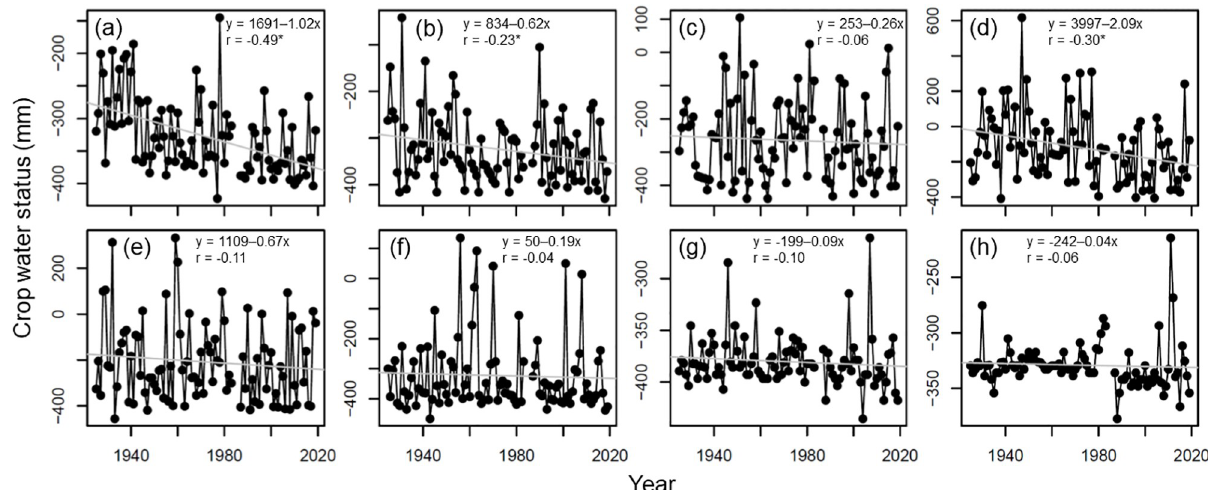
Fig 3. Yearly trend of crop water status on rice growth under initial (a and e), crop development (b and f), reproductive (c and g), and maturity (d and h) stages in cool (a, b, c, and d) and warm (e, f, g, and h) cropping seasons. Grey line represents the linear regression line. * represents p- value <